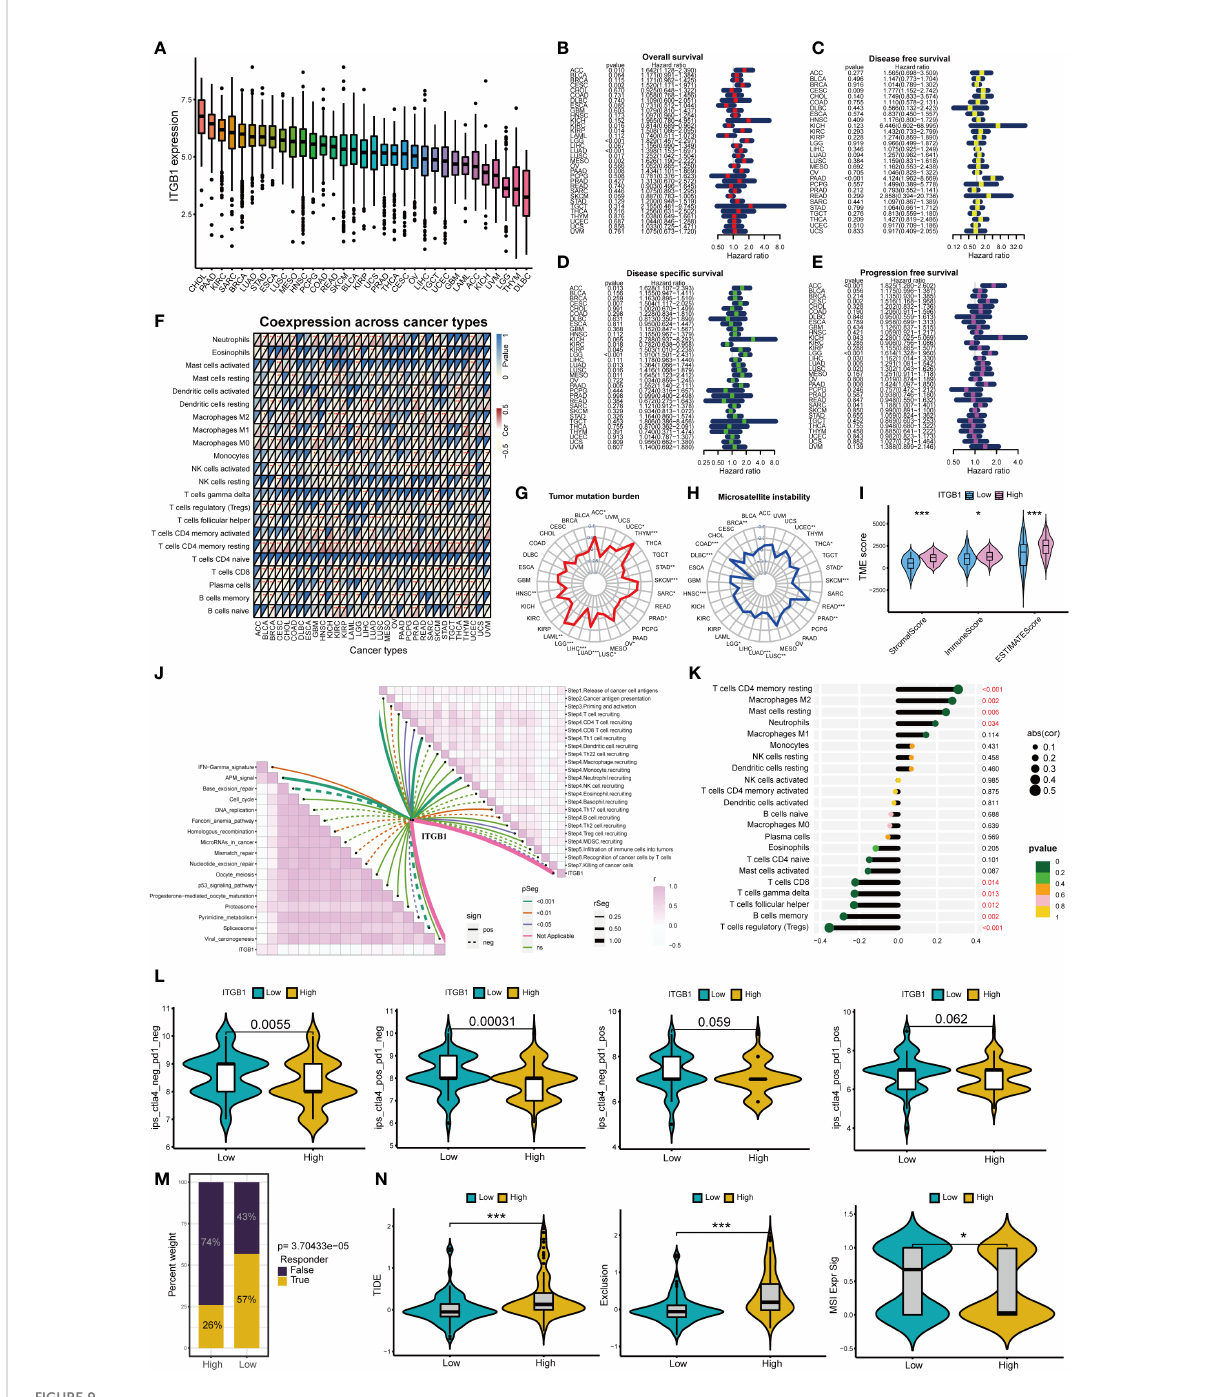
FIGURE 9 Analysis of ITGB1 in cancers *p<0.05; **p<0.01; ***p<0.001. (A) Expression of ITGB1 in 33 cancers. (B) Overall survival of ITGB1 in pan-cancer. (C) Disease free survival of ITGB1 in pan-cancer. (D) Disease special survival of ITGB1 in pan-cancer. (E) Progression free survival of ITGB1 in pan-cancer. (F) Co-expression analysis of ITGB1 and immune cells in pan-cancer. (G) Tumor mutation burden of ITGB1 in pan-cancer. (H) Microsatellite instability of ITGB1 in pan-cancer. (I) ESTIMATE analysis of ITGB1 high- and low-expression group. (J) Correlation between ITGB1, immunotherapy pathway and cancer immunity cycle. (K) Correlation analysis between ITGB1 and CIBERSORT immune cells. (L) Response rate of ICIs in ITGB1 high- and low-expression group. (M) Response of immunotherapy treatment in ITGB1 high- and low-expression group. (N) TIDE analysis of ITGB1 high- and low-expression